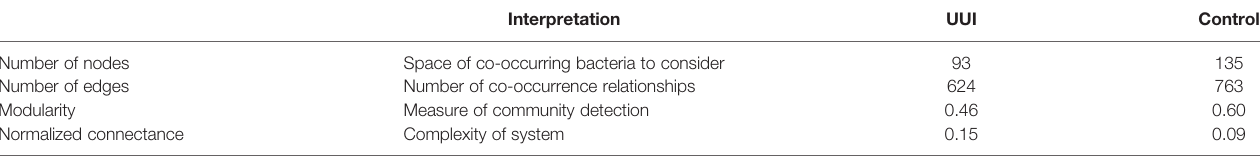
TABLE 6 | Summary of network metrics for bladder microbiome networks.